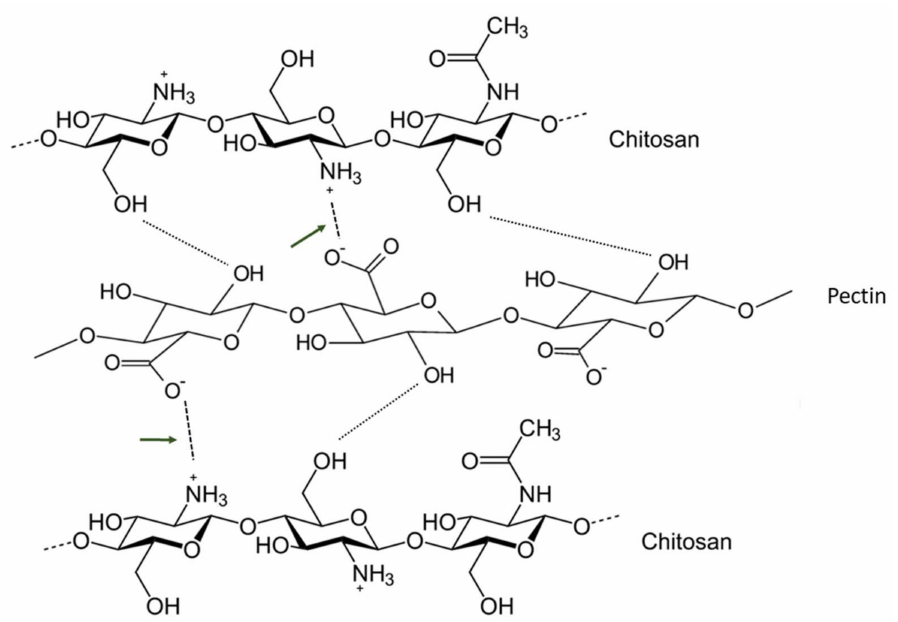
Figure 1. Electrostatic interaction between chitosan and